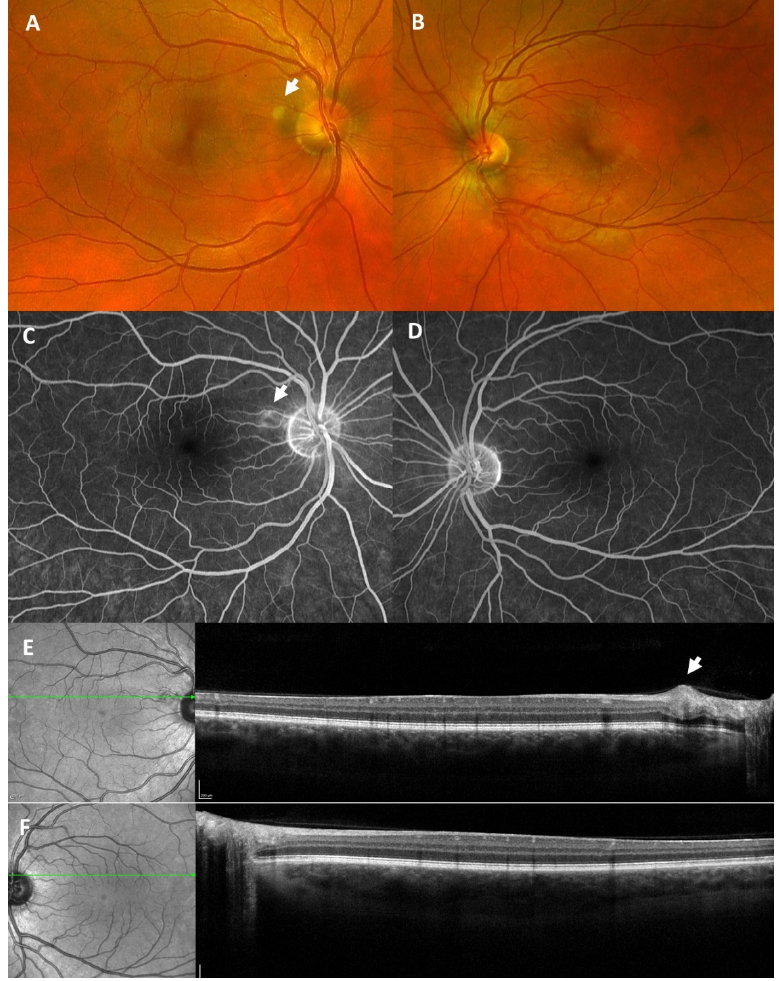
Figure 5. Fundus photography ( A , B ) revealed a cotton-wool spot temporal of the optic disc (white arrow) in the right eye ( A ) and was normal in the left eye ( B ). Fluorescein angiography ( C , D ) showed a hyperfluorescent spot (white arrow) corresponding to the cotton-wool spot in the right eye ( C ) and was normal in the left eye ( D ). Optical coherence tomography ( E , F ) revealed a circumscribed swelling of the retinal nerve fiber layer (white arrow) corresponding to the cotton-wool spot in the right eye ( E ) and was normal in the left eye ( F ). The green arrow indicates the position the OCT image was taken. The wide-field FFA showed normal filling and transit time. A focal area of